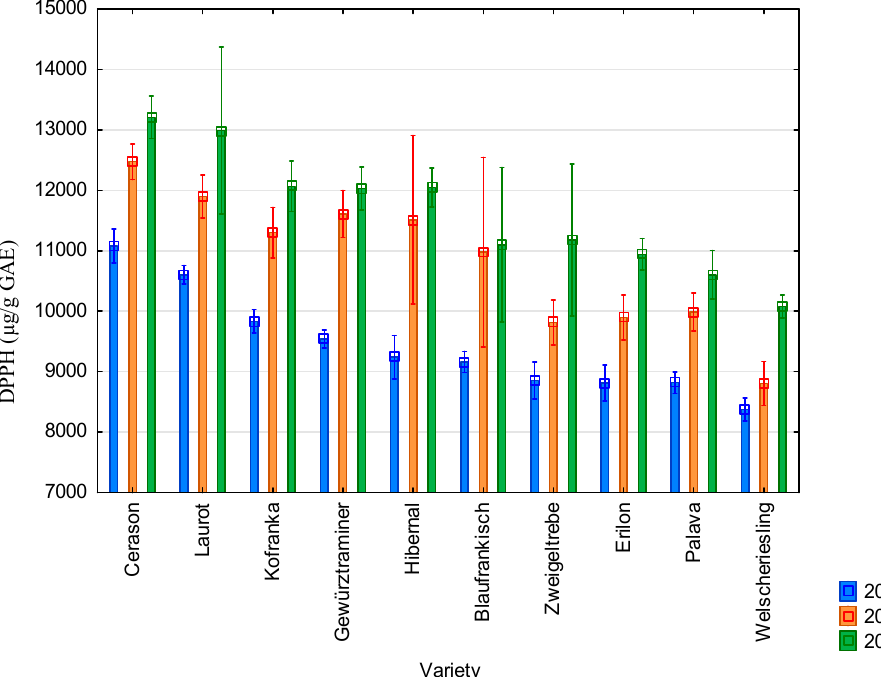
Figure 1. Values of antioxidant activity determined using the DPPH method for individual vine varieties in 2015 (blue bars), 2016 (orange bars), and 2017 (green bars). 2015: p < 0.01, 2016: p < 0.01, 2017: p < 0.01.